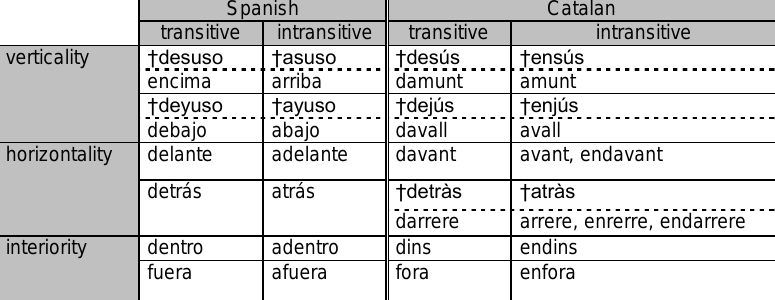
Table 1: Nominal or descriptive